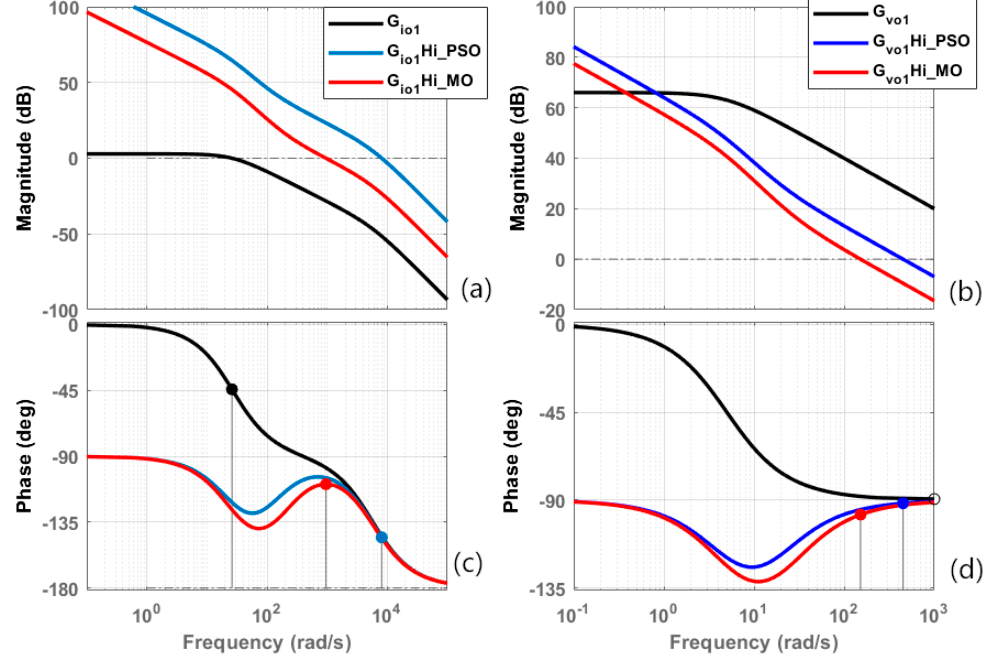
Figure 6. Comparison between PSO and MO tuning methods for open loop bode plots. ( a ) Magnitude plots for inner loop ( b ) Magnitude plots for outer loop ( c ) Phase plots for inner loop ( d ) Phase plots for outer loop